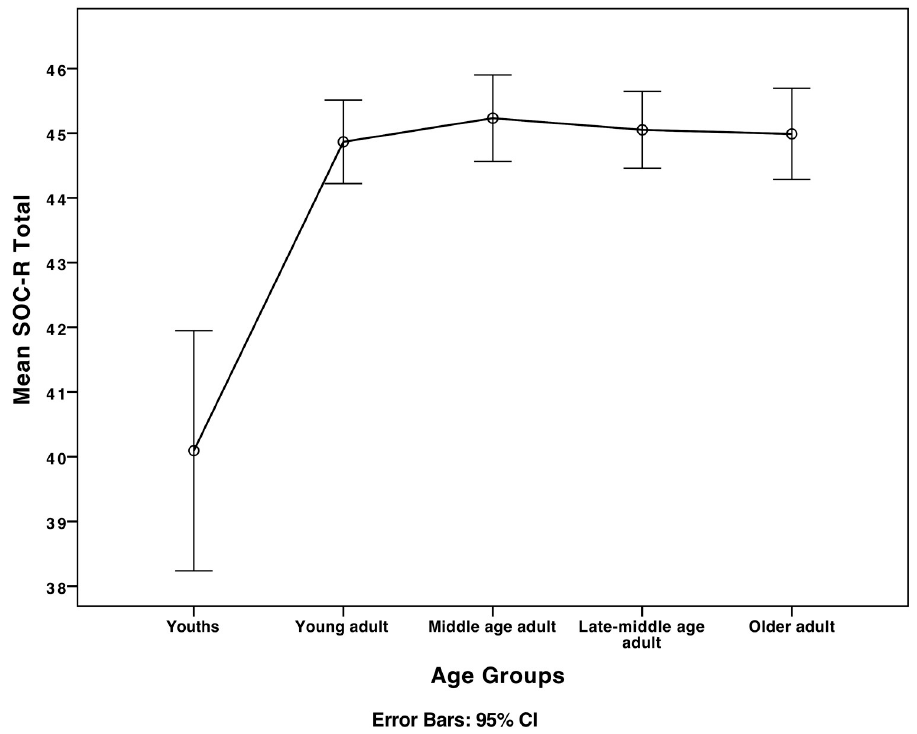
Fig 2. Plot of mean differences between age groups in revised sense of coherence (SOC-R) total.